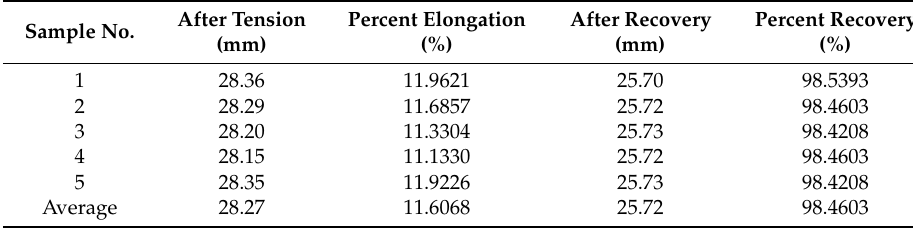
Table A5. DM8520.